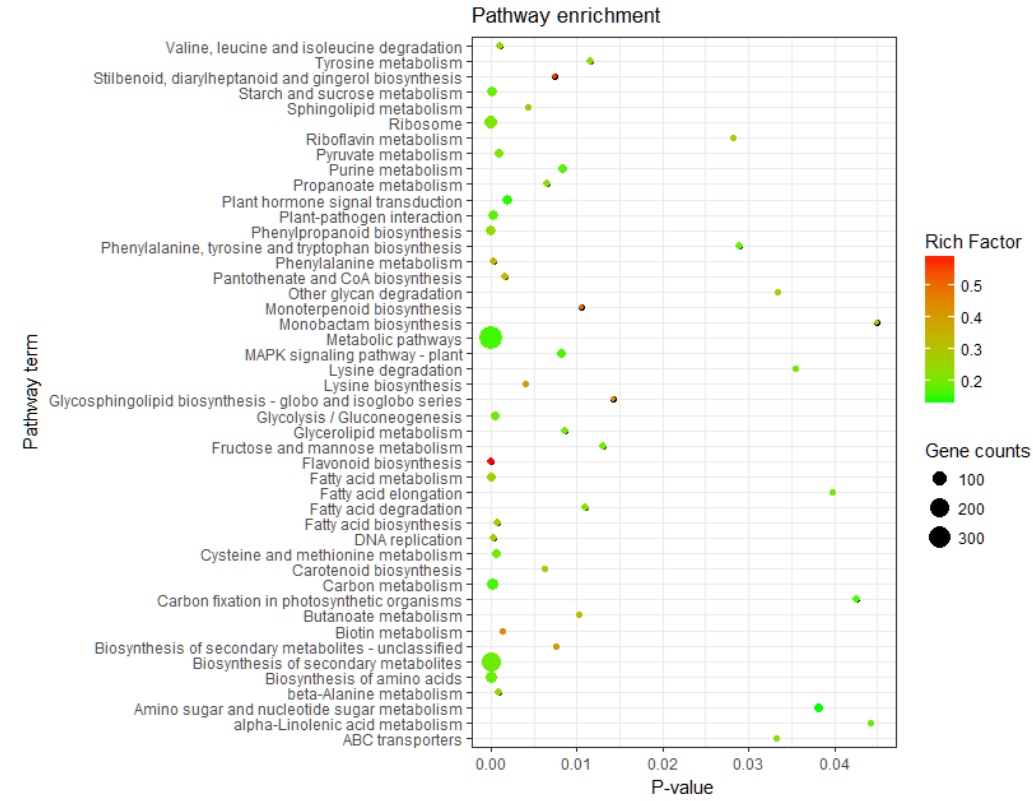
Figure 2. Pathway assignment of DEGs based on Kyoto Encyclopedia of Gene and Genomes (KEGG).